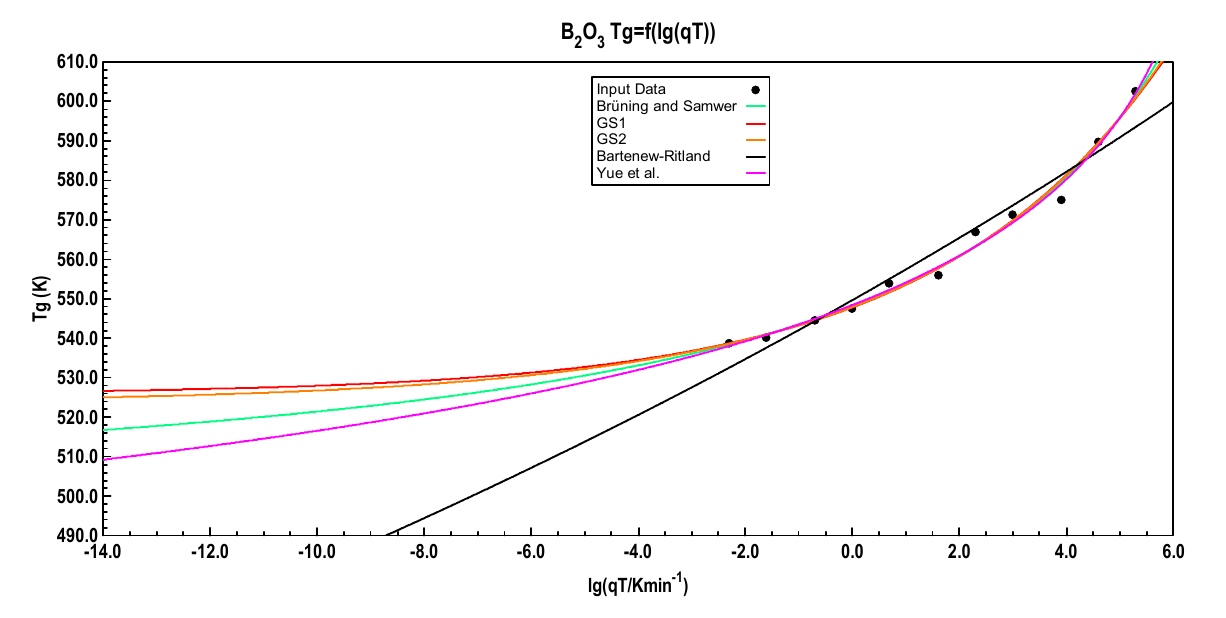
Figure 10. B 2 O 3 : behavior of equations to determine Tg 0 . The results for two metallic alloys are listed in Table 6 below. Table 6. Regression results for Pd 40 Ni 40 P 19 Si 1 and La 55 Al 25 Ni 20.